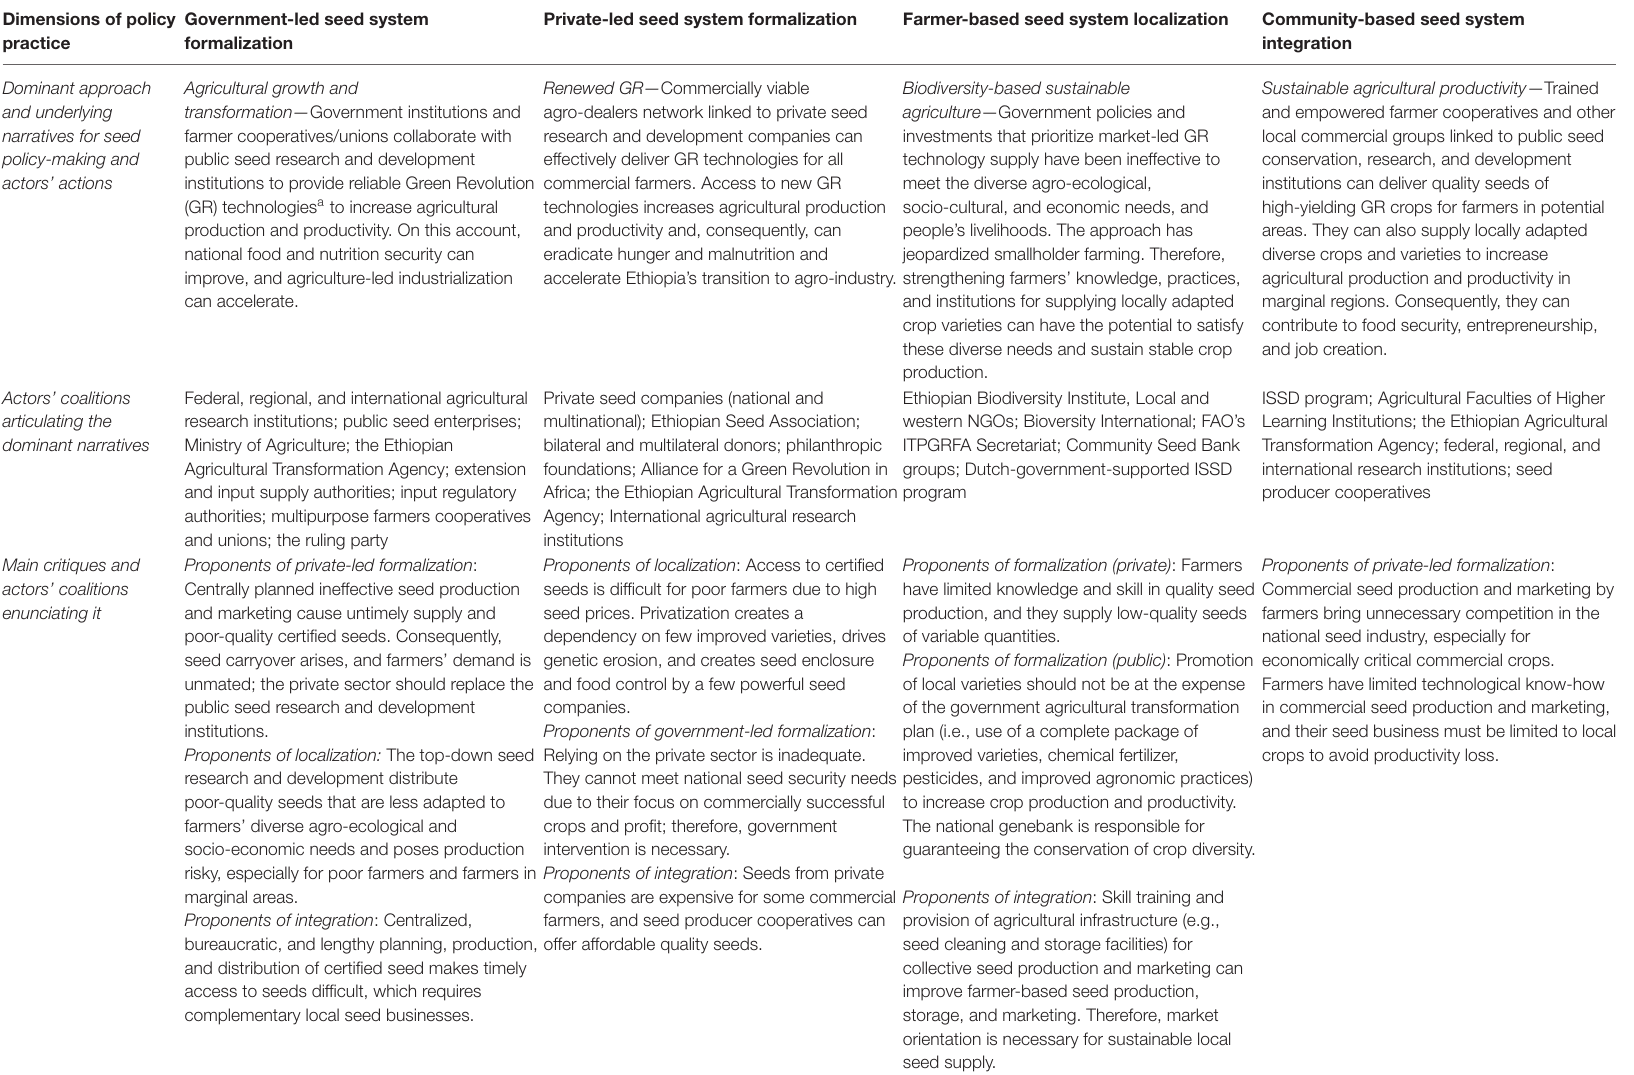
TABLE 1 | Dominant and alternative pathways to policy practices in Ethiopia’s pluralistic seed system